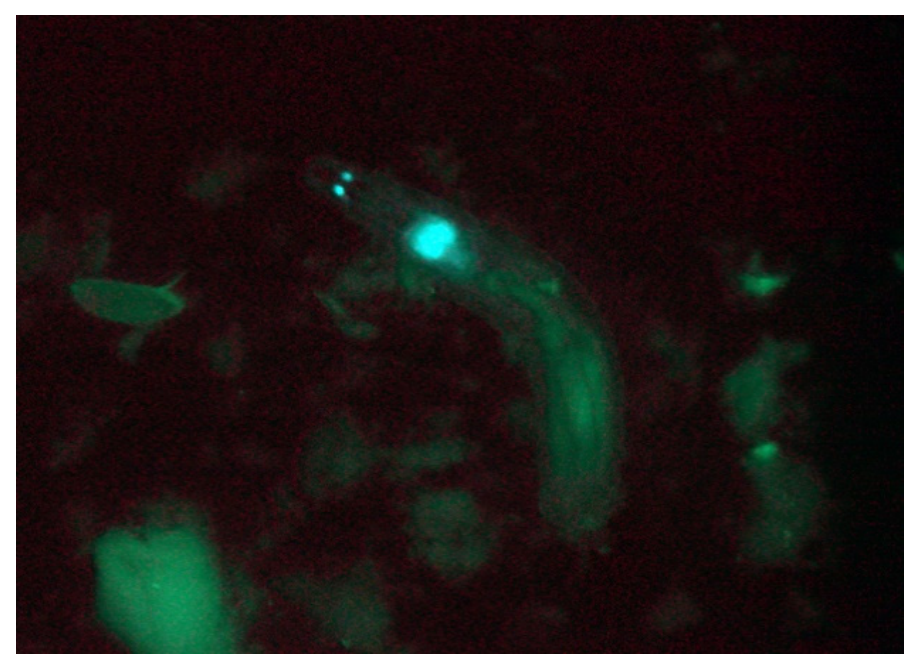
Figure 8. A transgenic D. guttifera larva showing enhanced green fluorescent protein (EGFP) expression in the Bolwig organs (two small glowing dots on the left) and the eye disks/brain (larger blob to the lower right) .